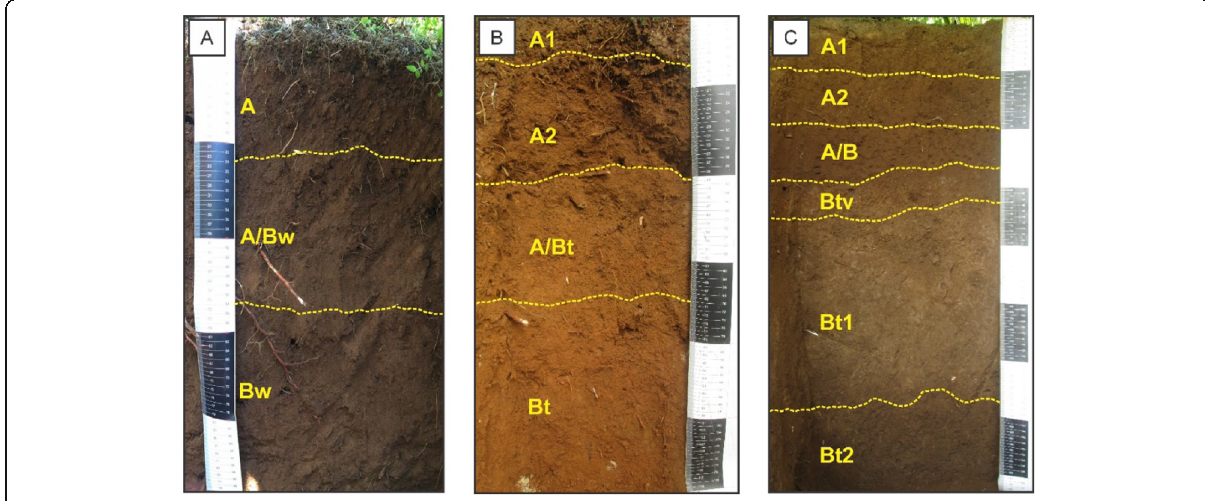
Fig. 4 Types of soil genetic horizon on crown part of landslide area: Tegalsari ( a ), Wonogiri ( b ), and Manglong ( c